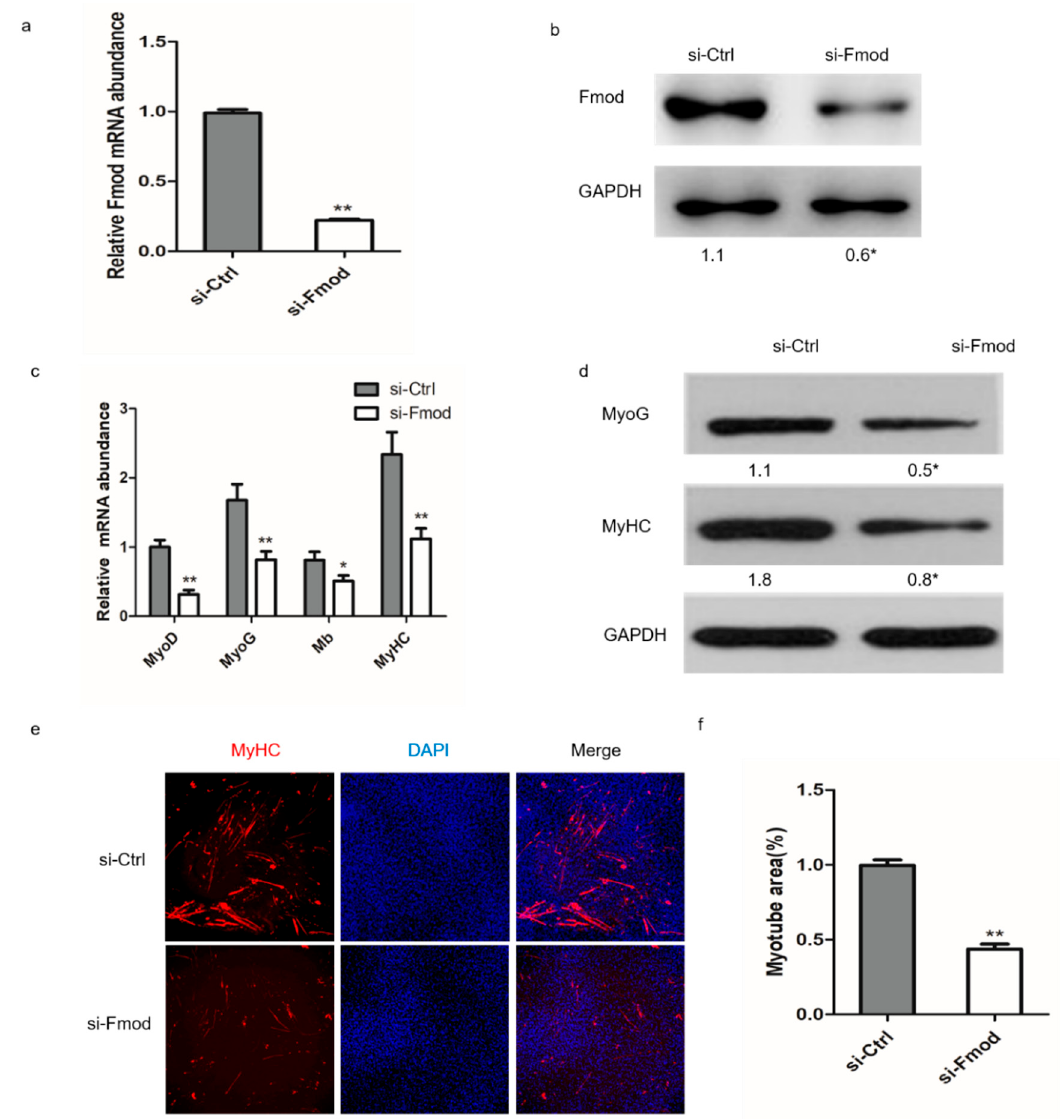
Figure 2. Effect of Fmod interference on chicken primary myoblast differentiation. ( a , b ) The Fmod mRNA and protein expression levels in myoblasts after transfection with Fmod siRNA or control siRNA for 48 h. ( c ) The MyoD, MyoG, Mb, and MyHC mRNA expression levels in myoblasts after transfection for 72 h. ( d ) Western blot analysis of MyoG and MyHC protein expression levels after transfection for 72 h. ( e ) Immunofluorescence of chicken myoblasts after transfection for 72 h. MyHc: red; DAPI: blue. ( f ) Myotube area (%) in myoblasts after transfection for 72 h. Note: * p < 0.05, ** p < 0.01.